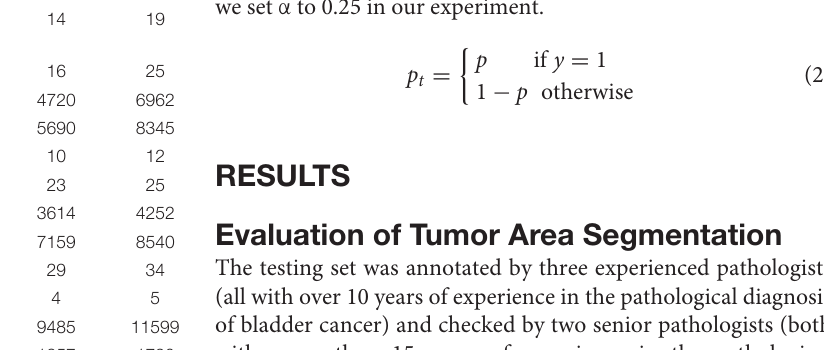
TABLE 2 | The overview of the dataset for molecular information recognition. Cohorts Training Validation